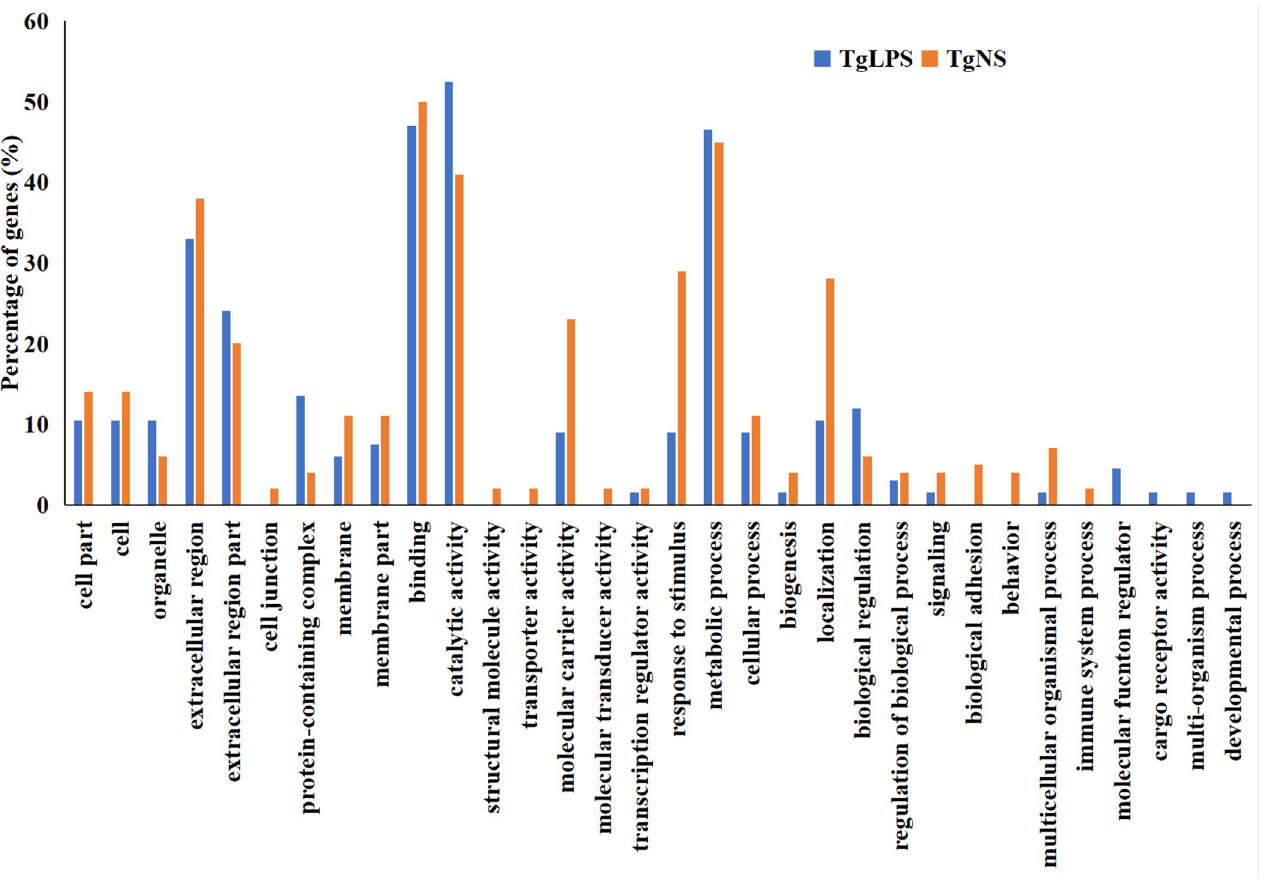
Fig 3. The gene ontology of the proteins identified in TgNS and TgLPS. The analysis was performed using PEAKS software. These proteins are either cellular components, have specific molecular functions or are involved in the biological processes. TgNS, non-stimulated T . gigas hemocytes; TgLPS, lipopolysacharride-stimulated T . gigas